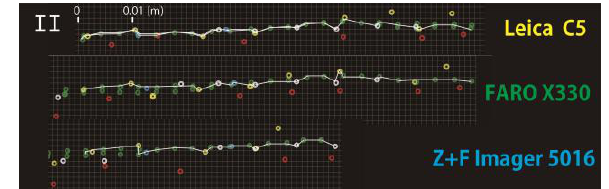
Figure 16: An example of common lines in Leica C5, FARO X330 and Z+F in